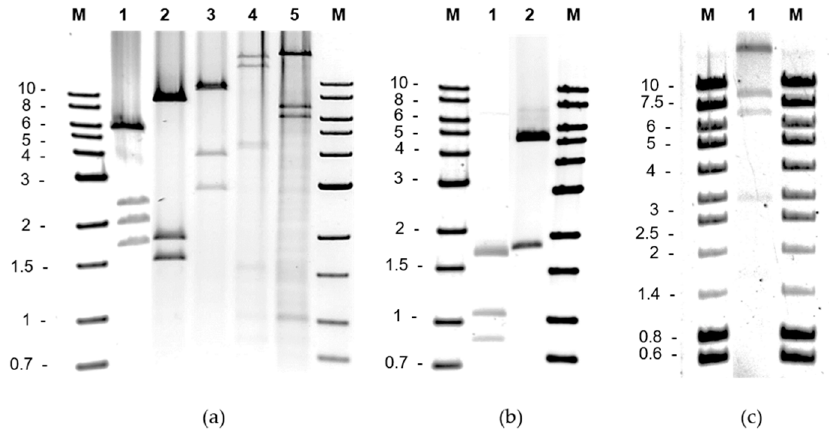
Figure 1. Restriction profiles of plasmid DNA obtained from transformants of tetracycline-resistant Lactococcus lactis NZ9000 ( a ), tetracycline-resistant Lacticaseibacillus casei BL23 and Lactiplantibacillus plantarum NC8 ( b ), and erythromycin-resistant L. lactis NZ9000 ( c ). Order: Panel ( a ), lanes 1 through 5, pTC1 to pTC5 digested with EcoRI; Panel ( b ), lanes 1 and 2, pTC6, and pTC7 digested with HindIII; Panel ( c ), lane 1, pERM1 digested with PvuI and EcoRI. M, Molecular weight markers.